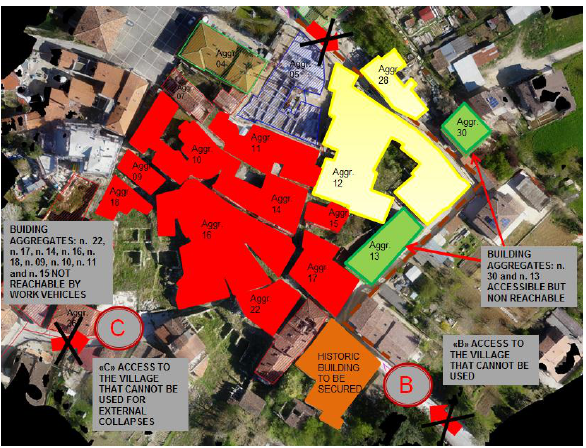
Figure 6. Analysis of the critical issues